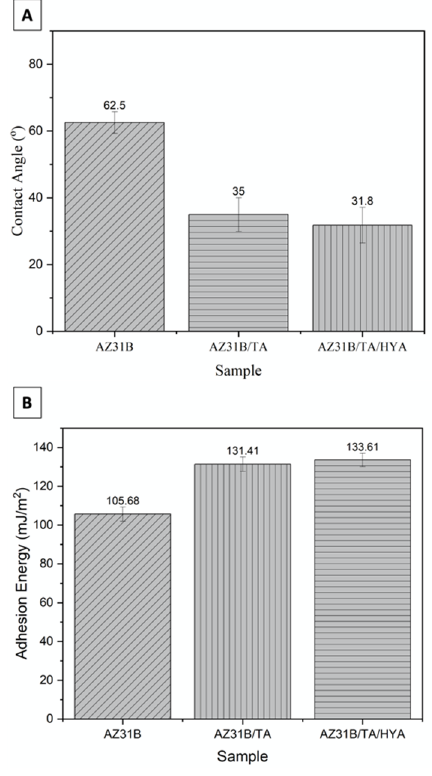
Figure 3. ( A ) Water contact angle data on samples AZ31B, AZ31B/TA, and AZ31B/TA/HYA; ( B ) Adhesion energy data on samples AZ31B, AZ31B/TA, and AZ31B/TA/HYA.